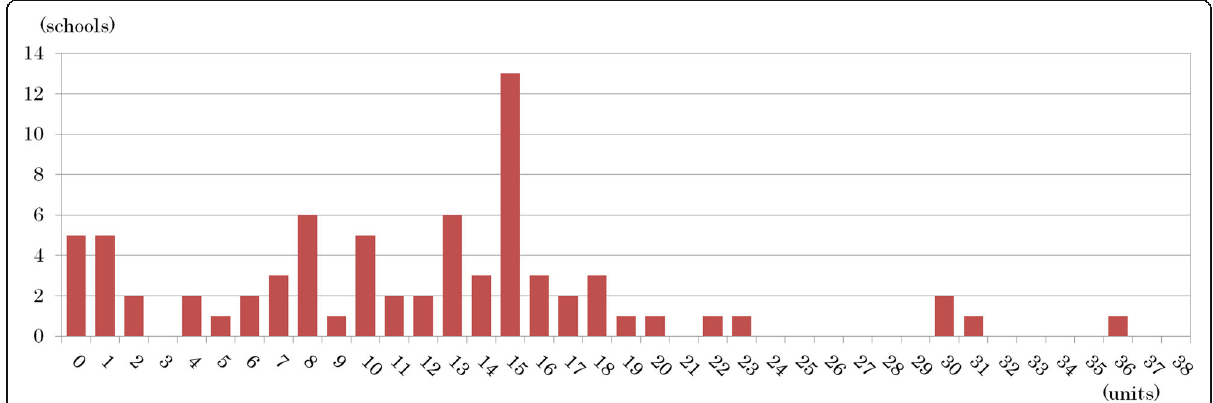
Fig. 1 The number of clinical Kampo classes, except for pharmacognosy, pharmaceutical botany, natural products chemistry, complementary and alternative medicine other than Kampo medicine and/or practical training, as required subjects during the 6 years of pharmacy schools as of 2015 (range, 0 – 36; mean, 11.8 ± 7.6; median, 13 classes). These data were extracted in detail from Web-based syllabi and by referring to the questionnaires collected from 74 pharmacy schools